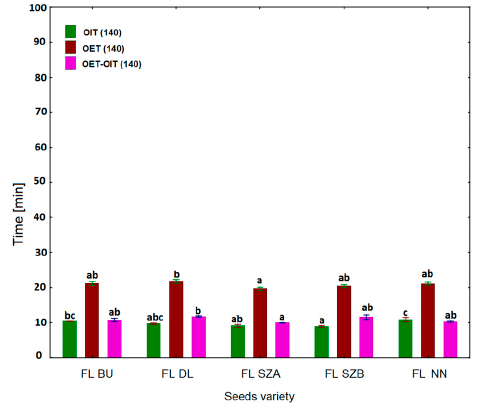
Figure 6. Oxidative stability parameters of five cold ‐ pressed flaxseed oils determined isothermally by DSC at 140 °C: Oxidation induction time OIT (min), oxidation end time OET (min), the oxidation duration Δ t (min). Different letters (a, b, c) indicate significant differences ( p < 0.05). FL BU (Bukoz Flaxseed cultivar), FL DL (Dolguniec Flaxseed cultivar), FL SZA, FL SZB (Szafir